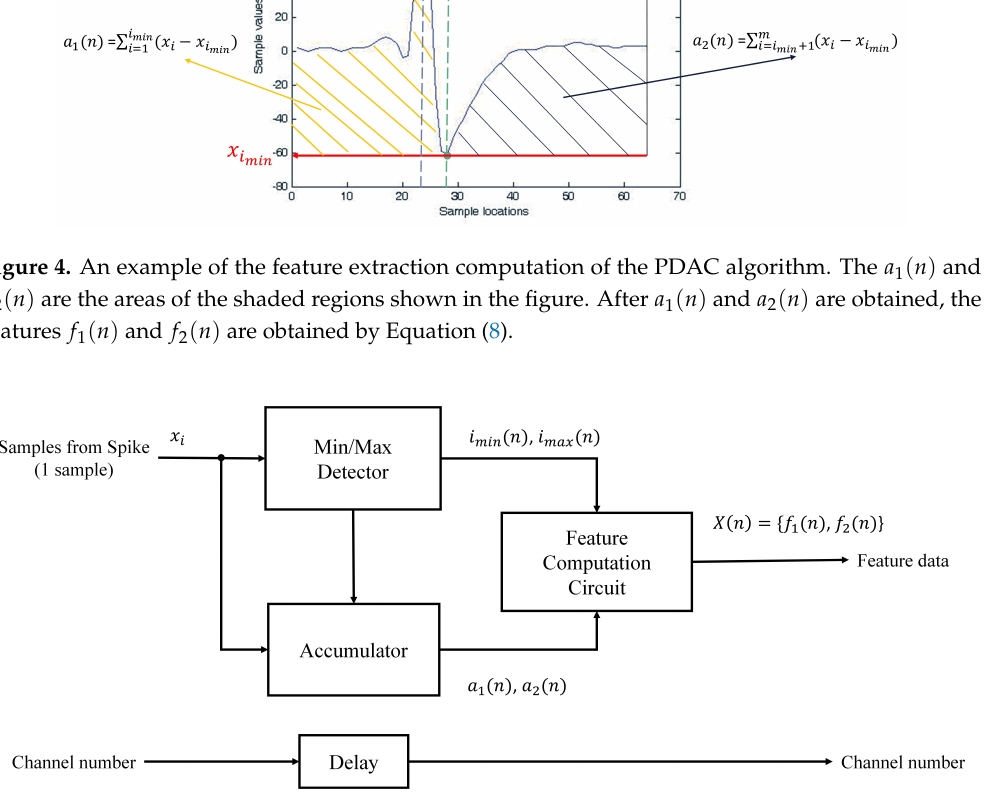
Figure 5. The block diagram of feature extraction circuit. It contains the min/max detector, accumulator and feature computation circuit. Both the min/max detector and accumulator are operated concurrently to expedite the